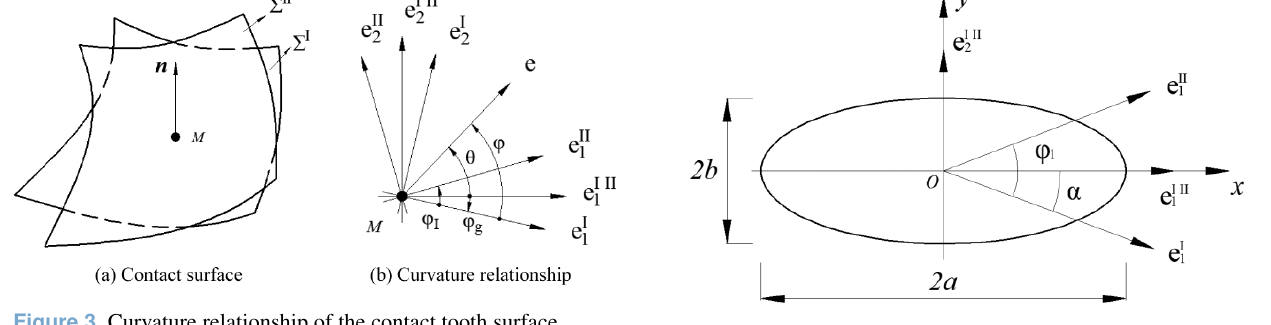
Figure 4. Contact